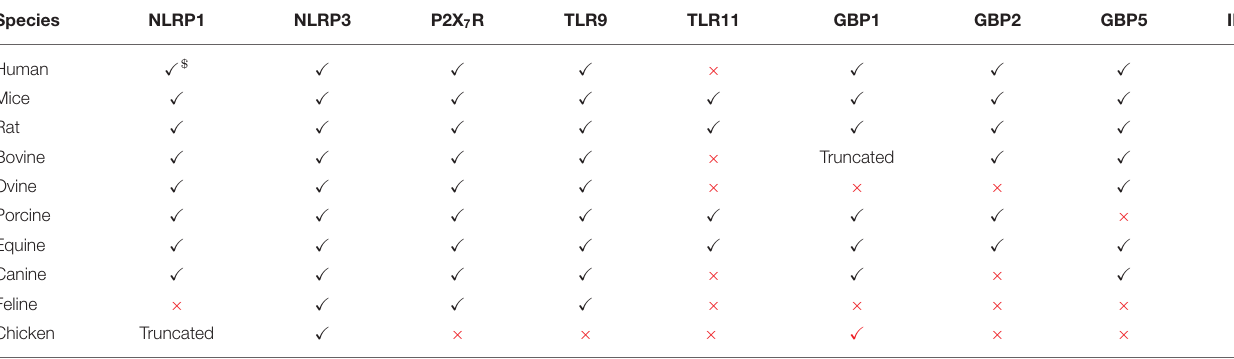
TABLE 1 | Immune genes that can induce toxoplasmacidal mechanisms and their functional status in different hosts.